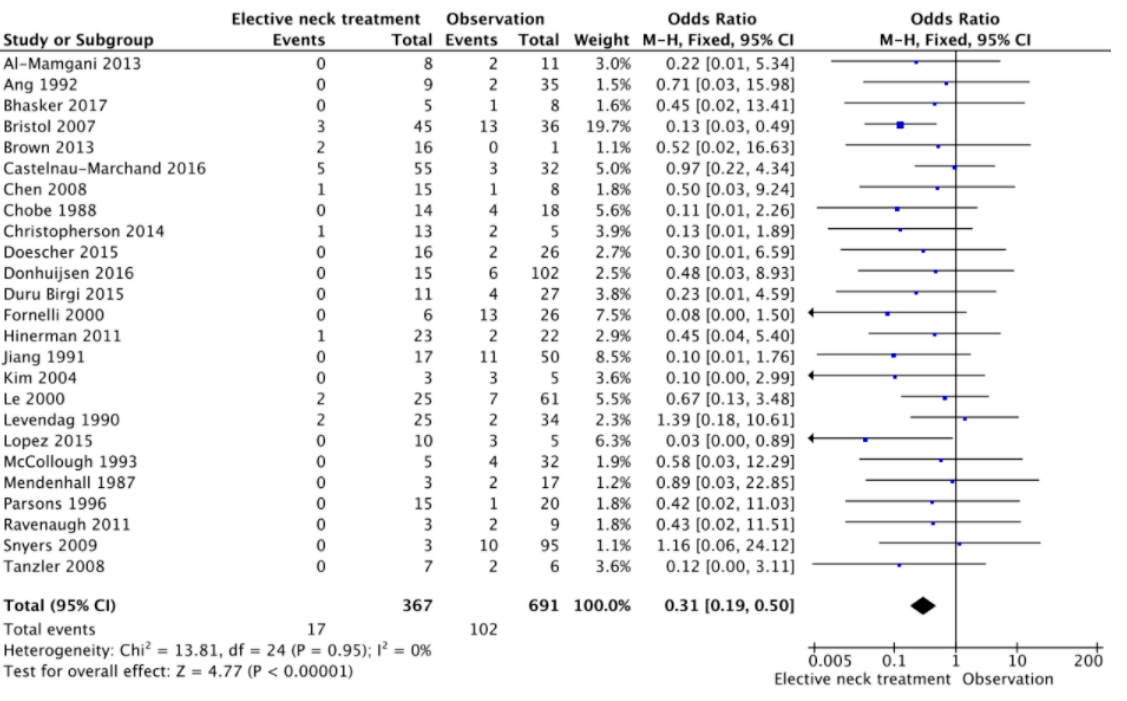
Figure 2. Forest plot of the present meta-analysis.